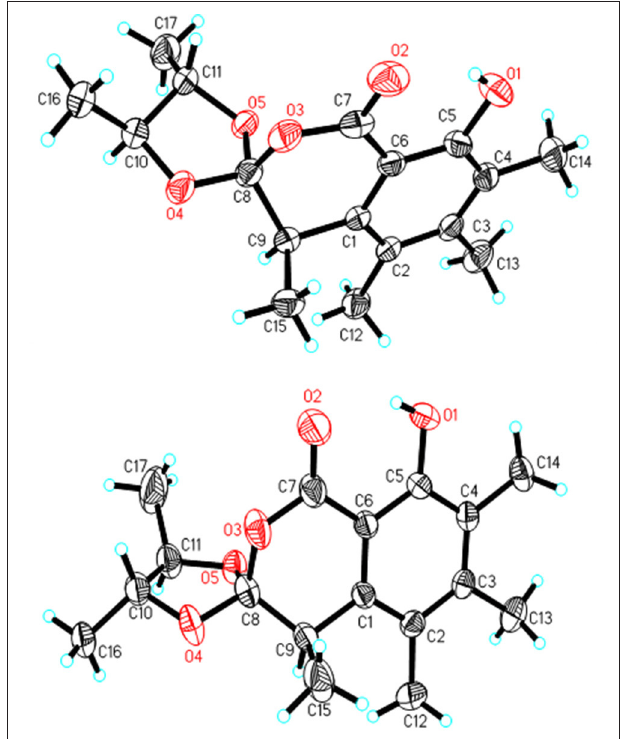
FIGURE 3 | X-ray structures of 1 and 2 .